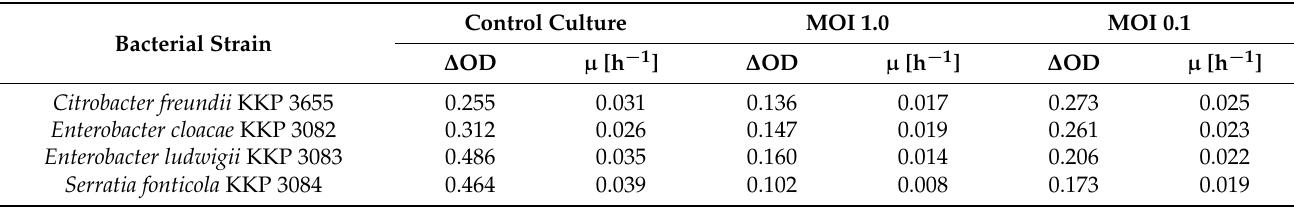
Table 3. Changes in the optical density of cultures of the examined strains after the addition of specific phages and values of the specific growth rate coefficient ( µ